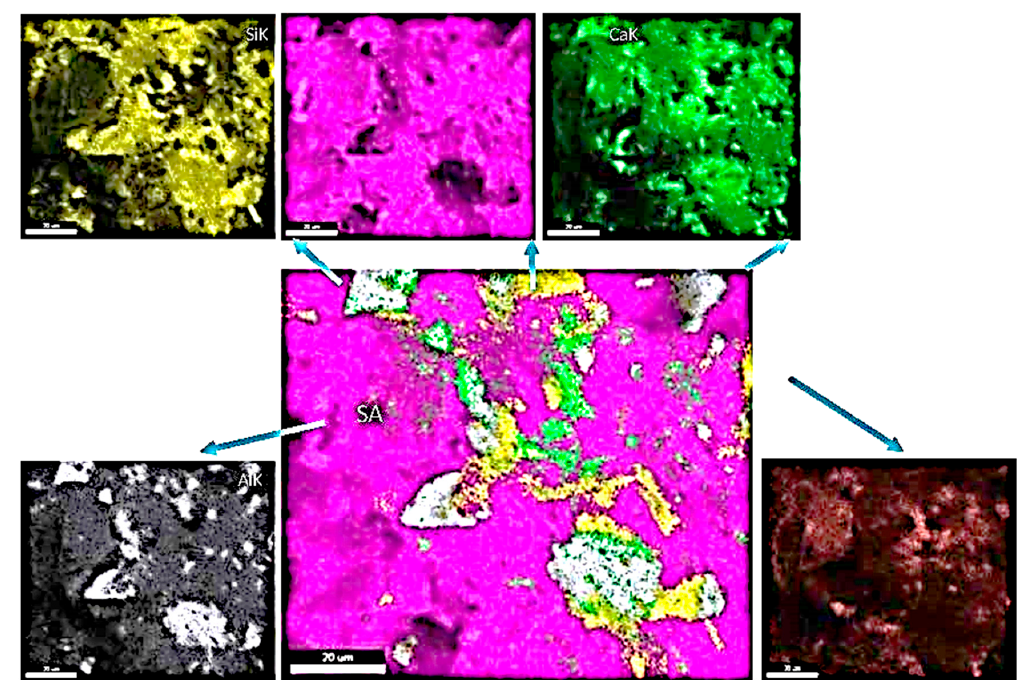
Figure 5. Element distribution from energy dispersive spectroscopy (EDS) mapping for P1AD1.